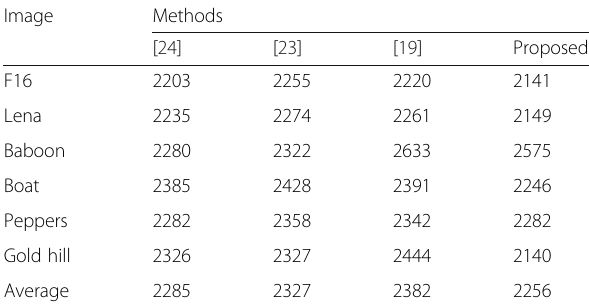
Table 6 File size increase (bytes) with payload size of